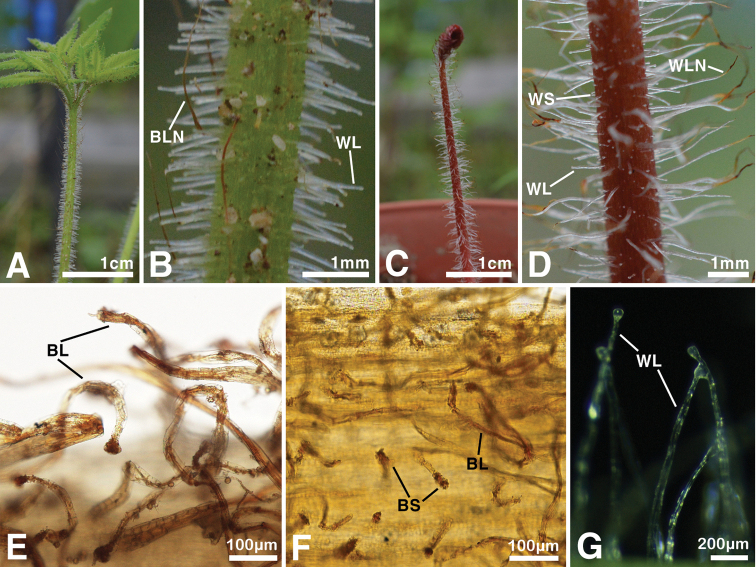
Shapes of trichomes on Astilbe
uljinensis and Astilbe
chinensisA, B, E, GA.
uljinensisC, D, FA.
chinensis. Abbreviations. BLN, Brownish Long Non-Glandular Hairs; WLN, Whitish Long Non-Glandular Hairs; WL, Whitish Long Glandular Hairs; WS, Whitish Short Glandular Hairs; BL, Brownish Long Glandular Hairs; BS, Brownish Short Glandular Hairs.